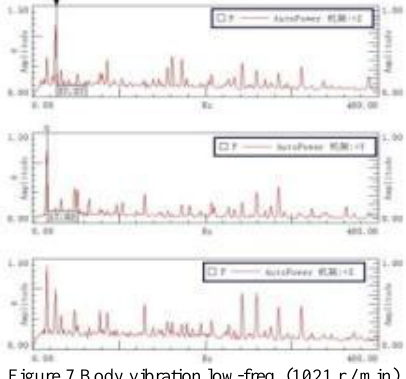
Figure 7 Body vibration low-freq. (1021 r /